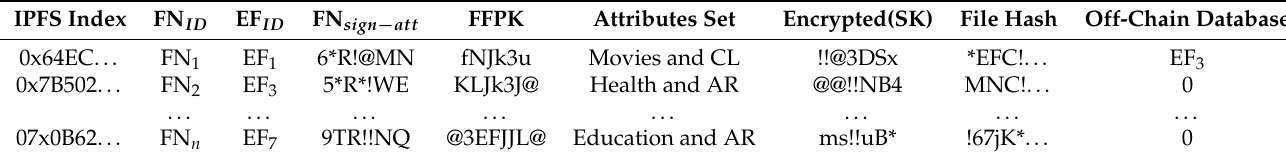
Table 3. On-chain tracking